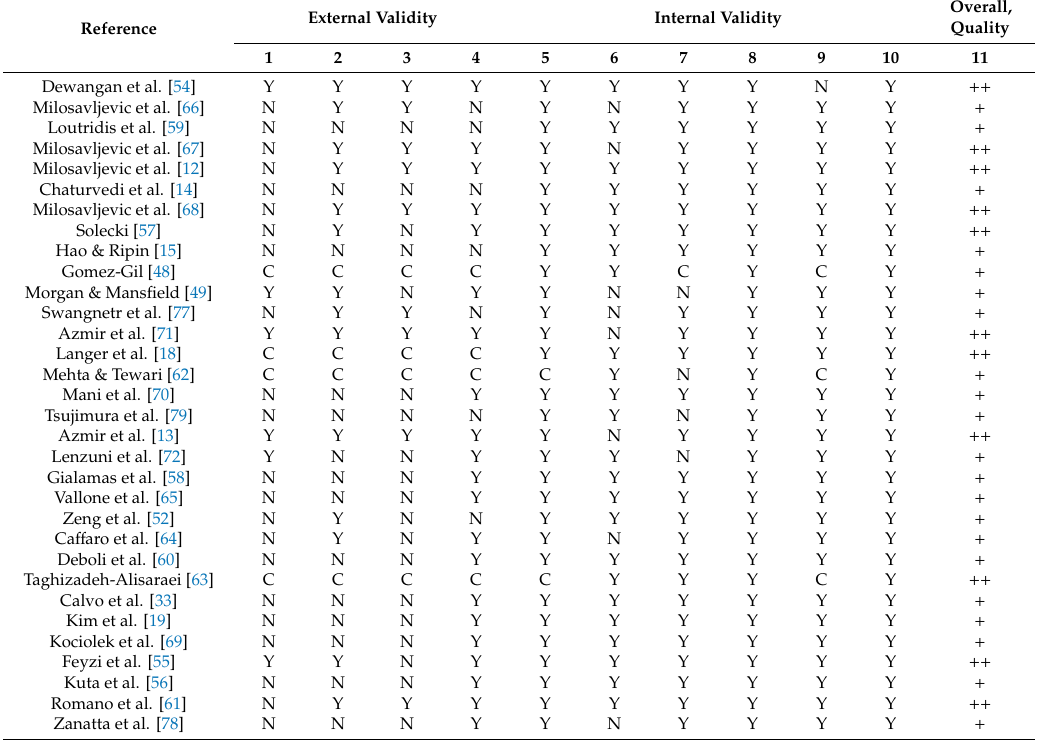
Table 1. Methodological quality scores of the selected journal papers; 1–4 items correspond to external validity criteria while 5–10 to internal validity criteria